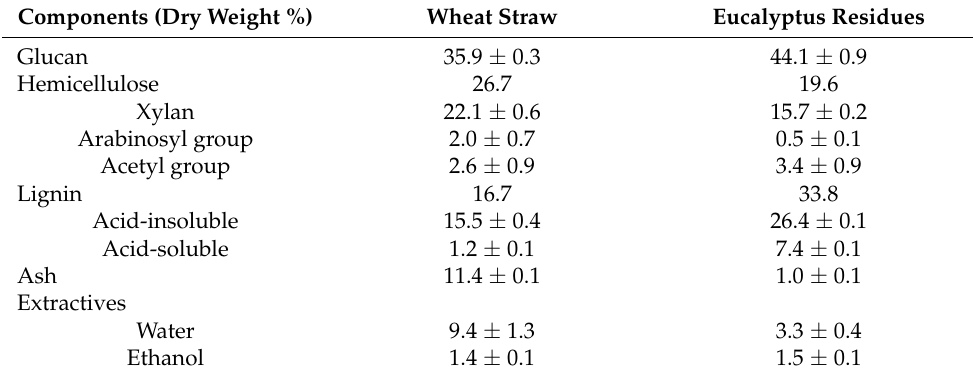
Table 1. Feedstock composition (wheat straw and eucalyptus residues).